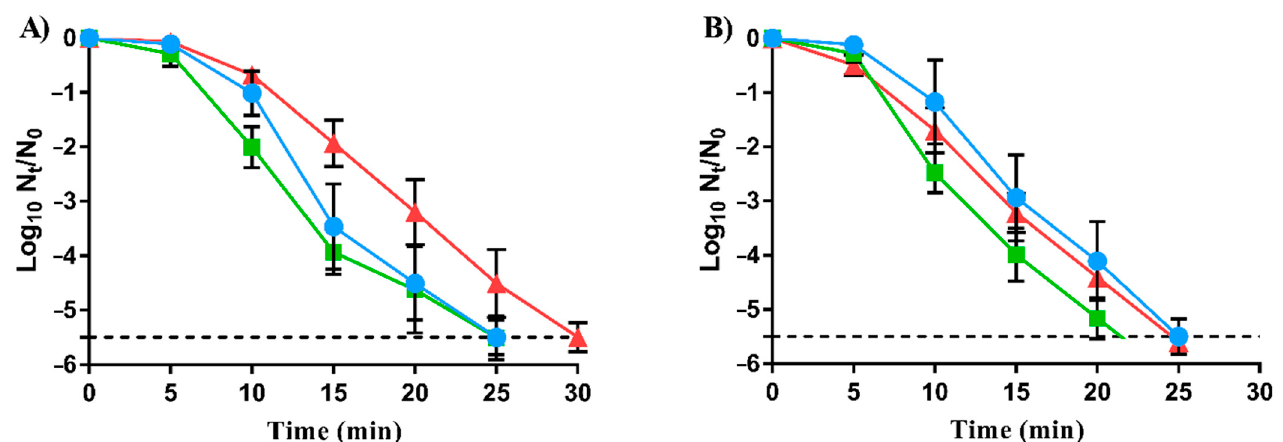
Figure 2. Survival curves of Listeria monocytogenes EGD-e ( ● ; LmWT) and its evolved strains, LmSCar ( ■ ; exposed to prolonged sublethal doses of carvacrol) and LmLCar ( ▲ ; cyclically exposed to short lethal treatments of carvacrol), to heat treatments: 54 °C at pH 4.0 ( A ); and 58 °C at pH 7.0 ( B ). Data are means ± standard deviations (error bars) obtained from at least three independent experiments. The dashed line represents the detection limit ( − 5.5 log 10 N t /N 0 ).